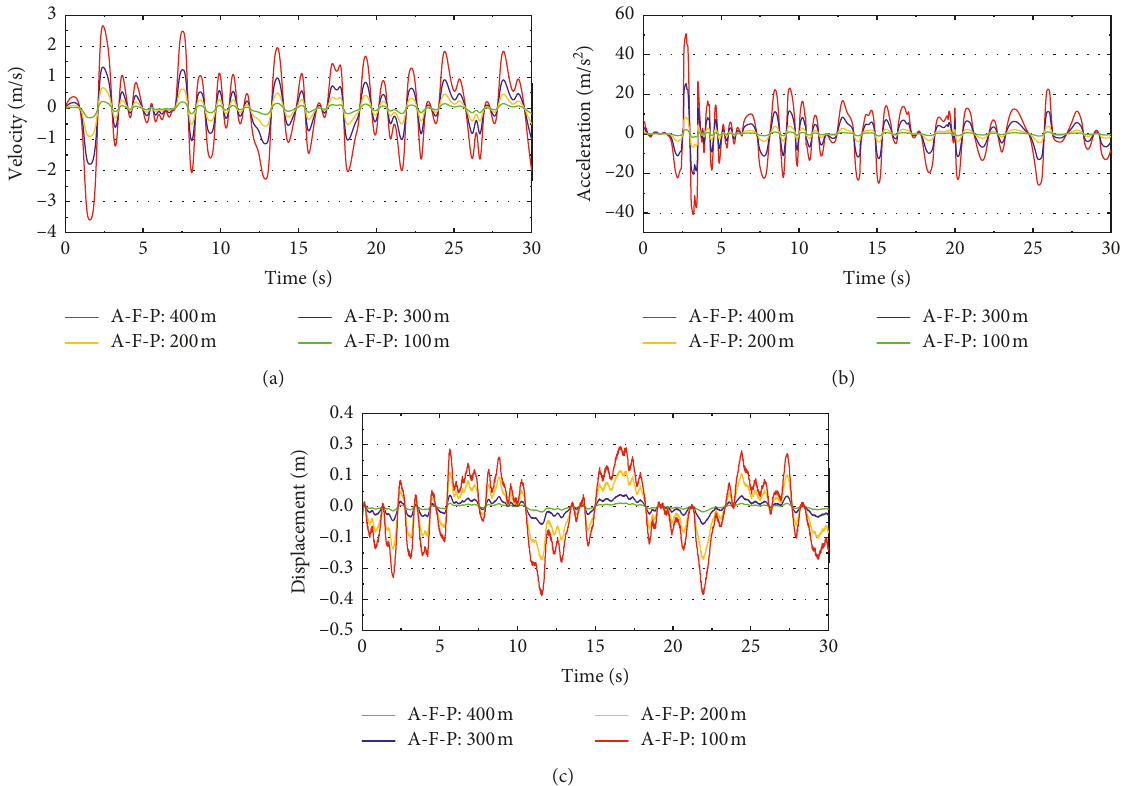
Figure 6: Curve of pipeline dynamic response analysis at different positions of the packer. (a) Axial velocity. (b) Axial acceleration. (c) Axial